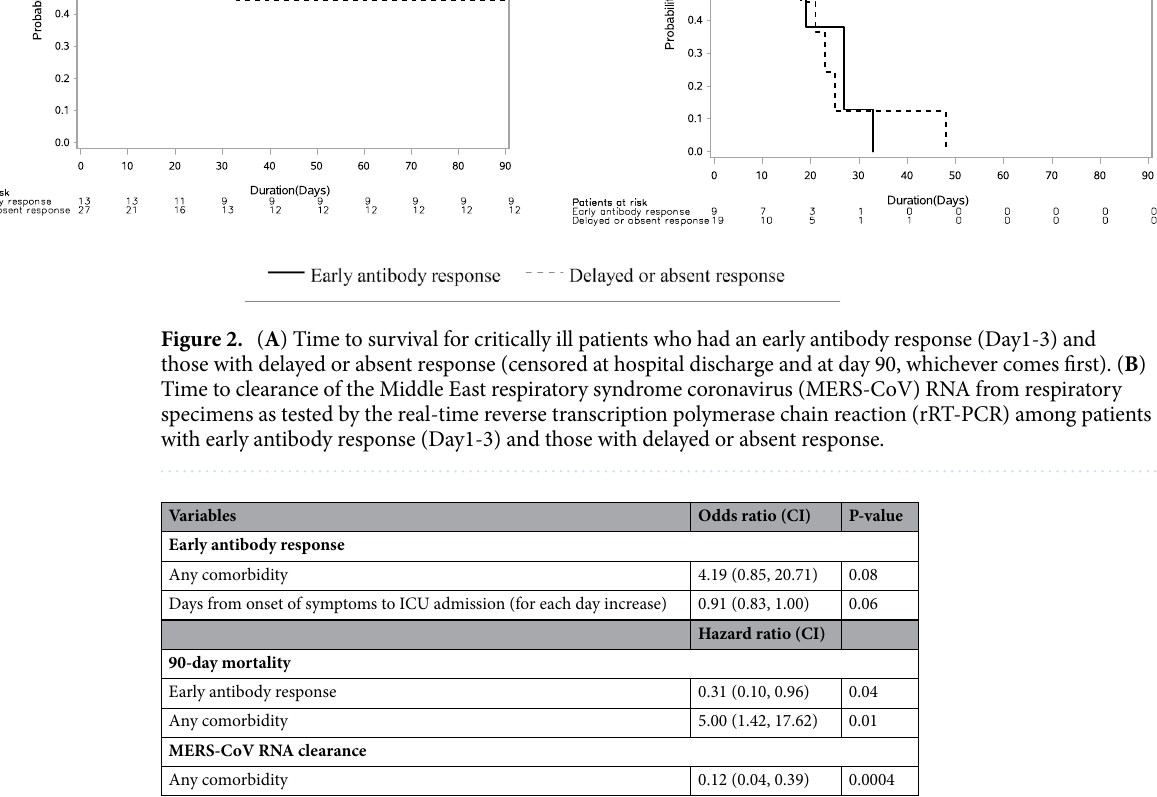
Table 3. Stepwise multivariate models to examine the independent predictors of 90-day mortality, early antibody response* and viral clearance among critically ill patients with Middle East Respiratory Syndrome (MERS). *Early antibody response = positive on day 1 or day 3; CI: Confidence Interval; ICU: Intensive care unit. All analyses were adjusted for age, any comorbidity, Sequential Organ Failure Assessment (SOFA) and days from onset of symptoms to ICU admission. For MERS-CoV RNA , hazard ratio < 1 signifies delay in clearance.